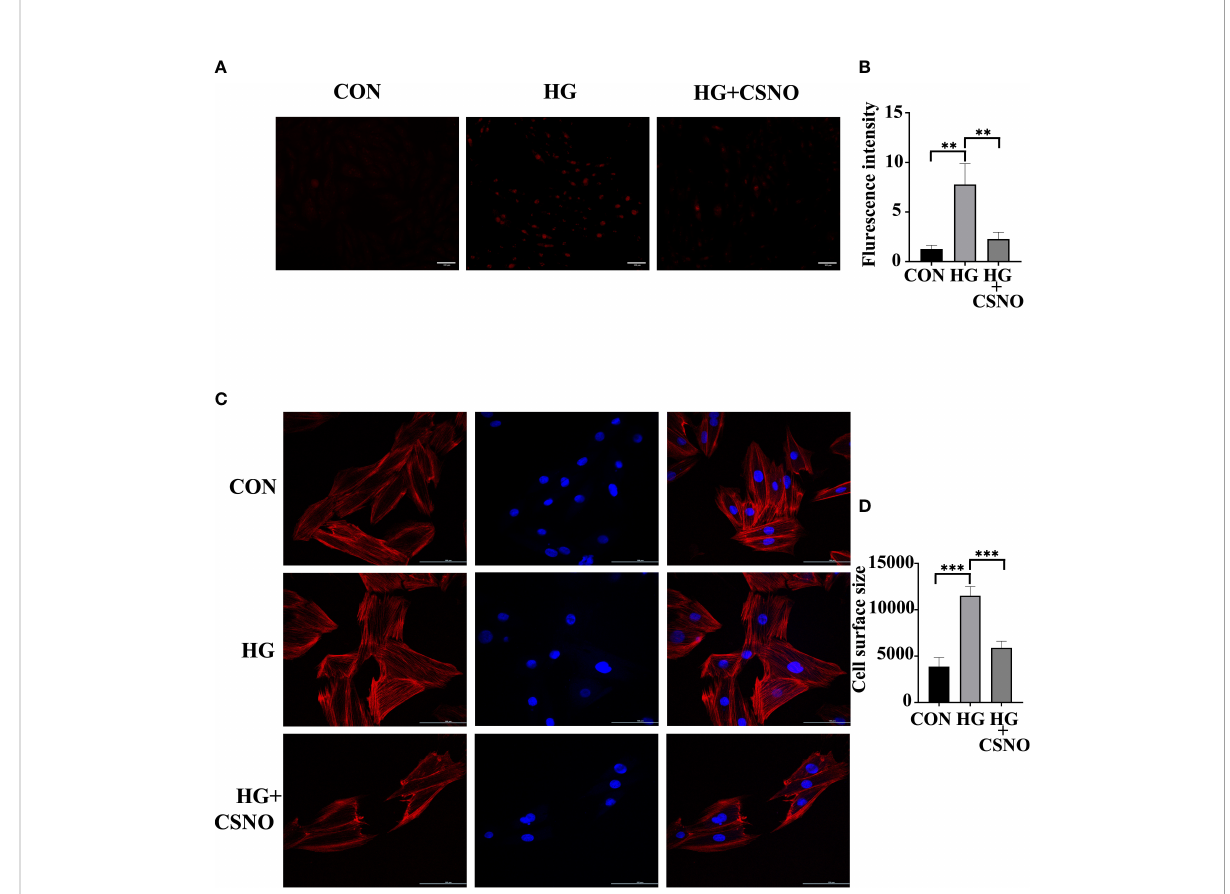
FIGURE 8 CSNO promoted high glucose-induced oxidative stress. (A, B) Analysis of reactive oxygen species (ROS) by dihydroethidium (DHE). Scale bar =100 m m. (C, D) The size of the cell was determined by detecting fi laments of F-actin in the cell cytoskeleton using phalloidin. Scale bar=100 m m. ** represents p < 0.01; *** represents p <